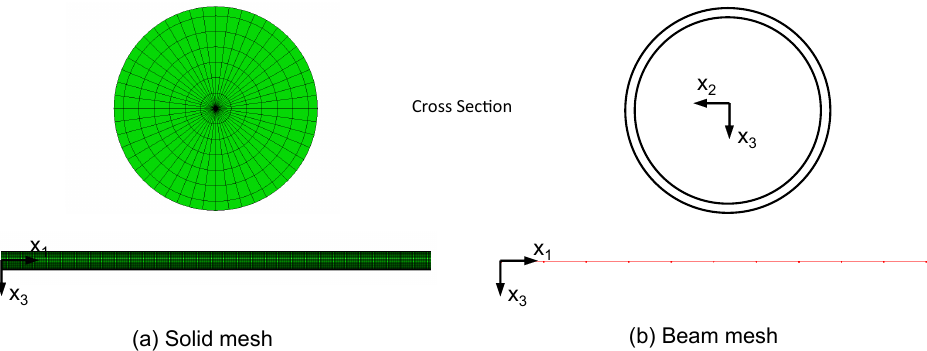
Figure 5. Finite-Element Mesh; ( a ) solid model, ( b ) beam model with schematic cross